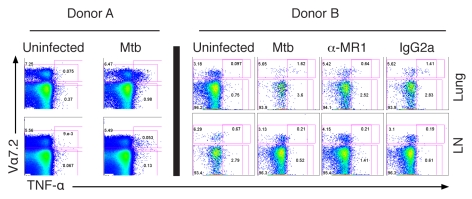
Mtb-reactive MAIT cells in the human lung.Single cell suspensions were prepared from the lung and adjacent LNs with minor modifications [52]. The intracellular cytokine staining assay was performed using magnetic-bead purified CD8+ T cells from the lung and LNs as described in Figure 6 legend. Only in the case of donor B were anti-MR1 or IgG2a isotype control antibodies added (2.5 µg/ml).